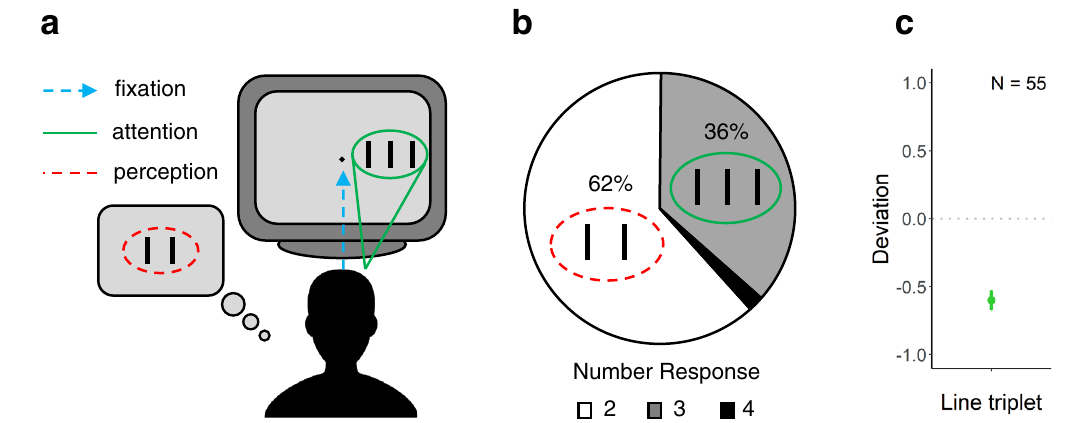
Figure 1. Illustration of redundancy masking ( a ), and results of Experiment 1 ( b , c ). ( a ) While fixating on the center (blue dashed arrow), observers attended to the stimulus in the periphery. When presented with three lines, most observers reported two lines. ( b ) Percentages of perceived numbers of lines. 61.8% of the observers reported perceiving a line pair, 36.4% reported a line triplet, and 1.8% reported a line quadruplet. ( c ) The average deviation score for the line triplet. Deviation scores were calculated by subtraction of the number of lines presented from the number of lines reported. Error bar shows ± SEM